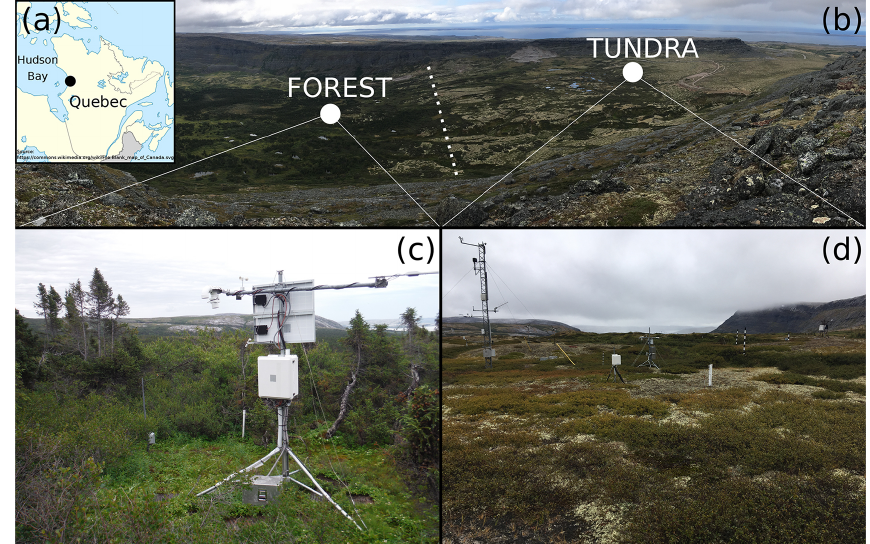
Figure 1. (a) Location of the study site on the eastern shore of Hudson Bay, Quebec, Canada. (b) View of the Tasiapik valley towards the southwest, where the bottom (left) is covered with trees and the top (right) with tundra. Note the presence of the cuesta that delimits the valley. (c) FOREST station. (d) TUNDRA station. The dotted line is the boundary between the forested area and the shrub and lichen tundra.